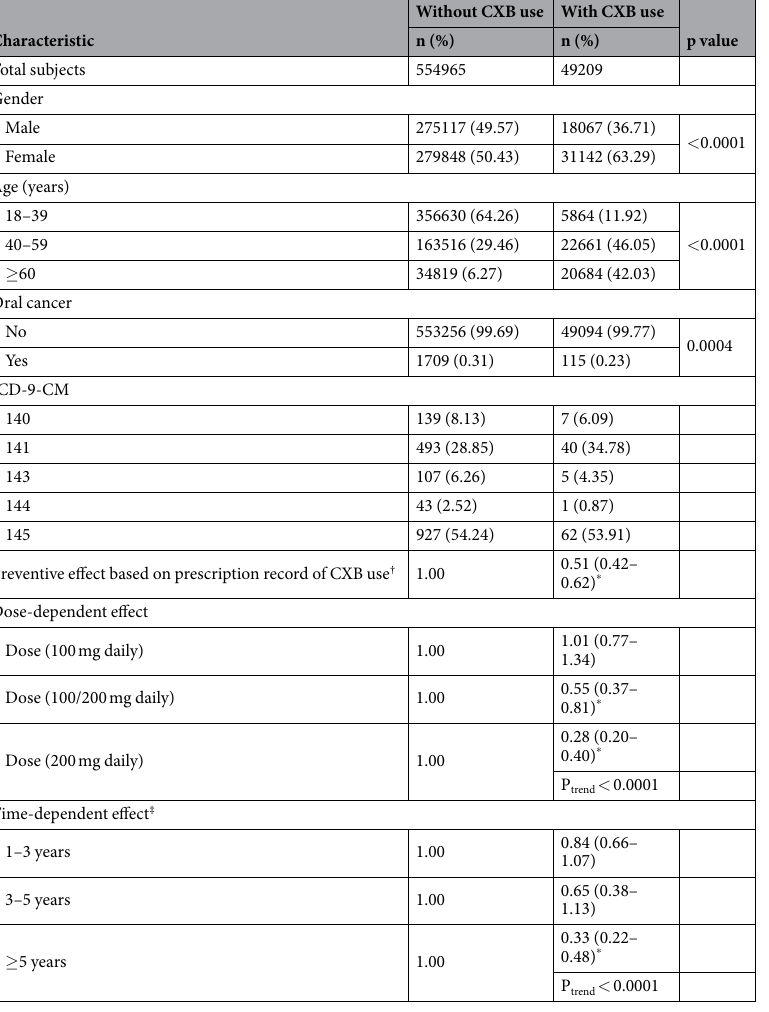
Table 2. CXB use associated with early prevention of oral cancer (Group 1) occurrence in a retrospective cohort study. † Hazard ratio was examined using a Cox proportional hazard model with adjustment for the age and gender in a cohort study followed up from 1997 to 2010. ‡ Follow-up years after the first CXB use. * p <